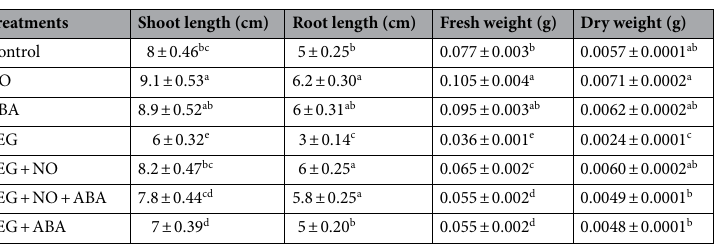
Table 1. Effect of PEG and its combination with NO and ABA (nitrate agonists) on length (shoot and root) and plant fresh and dry weight of 7-days-old B. juncea L. seedlings after 96 h exposure to the treatments. Values are mean ± S.E. of three independent experiments, each including four biological replicates. Different letters within the same column represent significant difference between treatments, where “a” corresponds to the highest value and “d” or “e” to the lowest